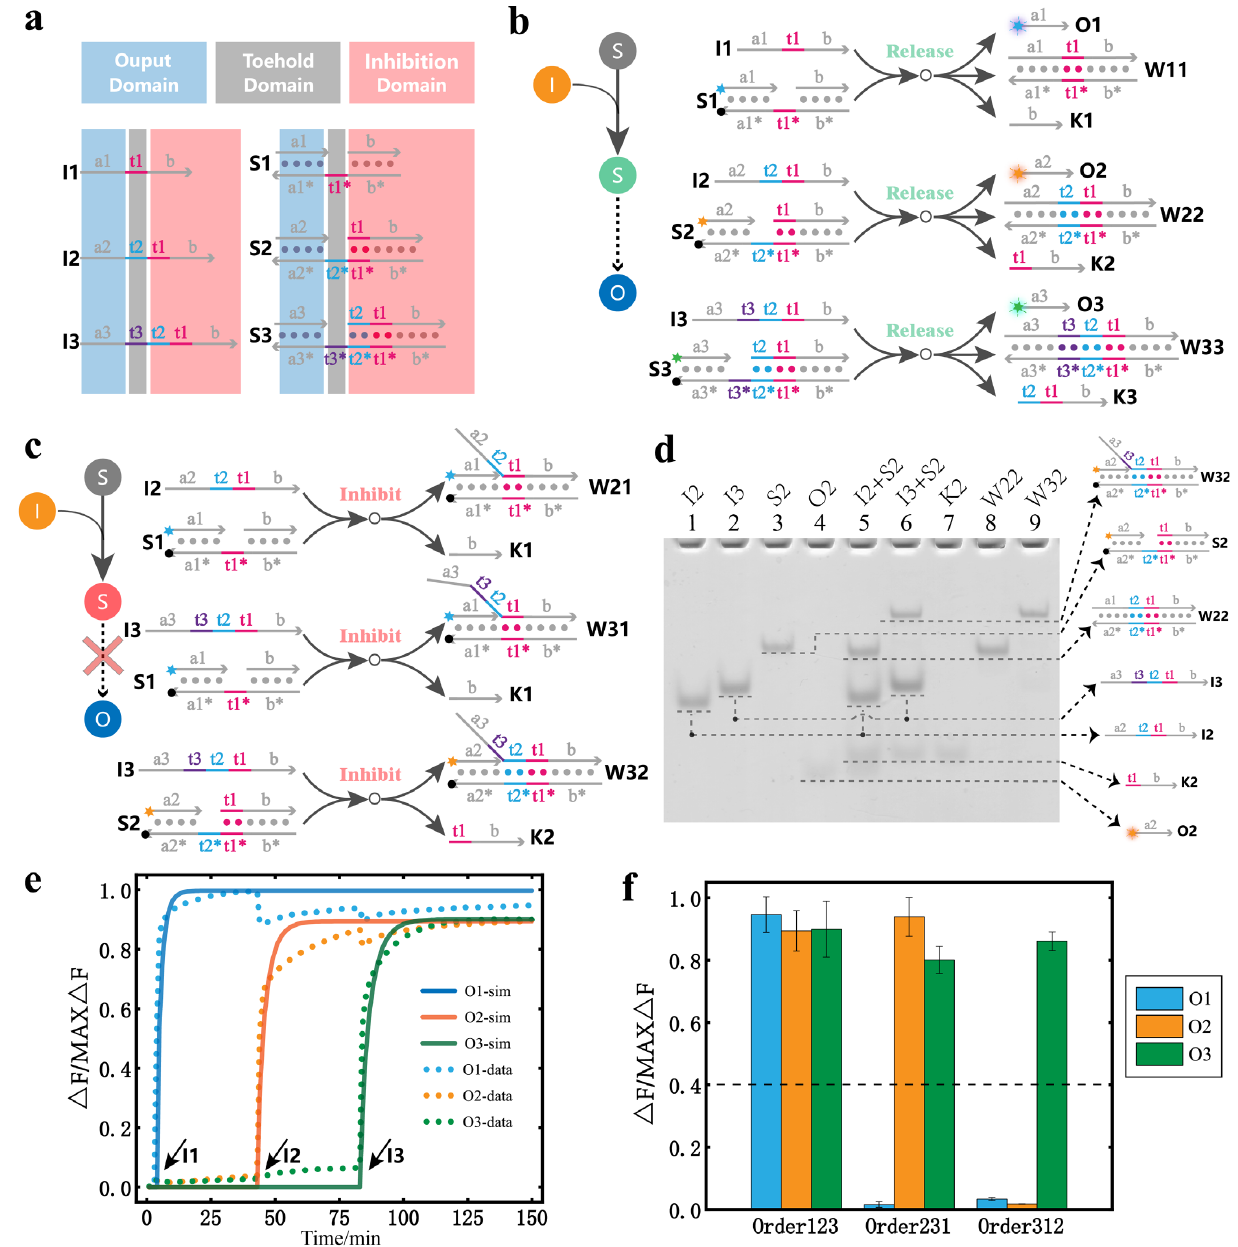
Figure 2. Design and implementation of the DNA temporal logic circuit. ( a ) The design of the DNA temporal logic circuit. Blue represents the output domain; gray represents the toehold domain; red represents the inhibition domain. ( b ) The strand displacement reaction process for all release reactions. ( c ) The strand displacement reaction process for all inhibition reactions. ( d ) Polyacrylamide gel electrophoresis was used to analyze the release reaction and inhibition reaction of S2. The top of the gel was marked with the reference of the reactant, the reference of the product, the results of the release reaction, and the results of the inhibition reaction of the substrate S2 ([I1] = [I2] = [I3] = 2400 nM, [S2] = 800 nM). ( e ) Fluorescence kinetics. S1, S2, and S3 were added to the solution before input. The reaction temperature was 37 °C, and the frequency was 1 data point per minute. The order of the input was I1, I2, and I3, and the time interval of the input was 40 min ([S1] = [S2] = [S3] = 120 nM, [I1] = [I2] = [I3] = 400 nM). ( f ) Bar graph of the output fluorescence signal with different orders of inputs. The dashed line marks the separation between the output results 0 and 1. All the asterisks in the figure indicates the complementary strand of the corresponding strand .